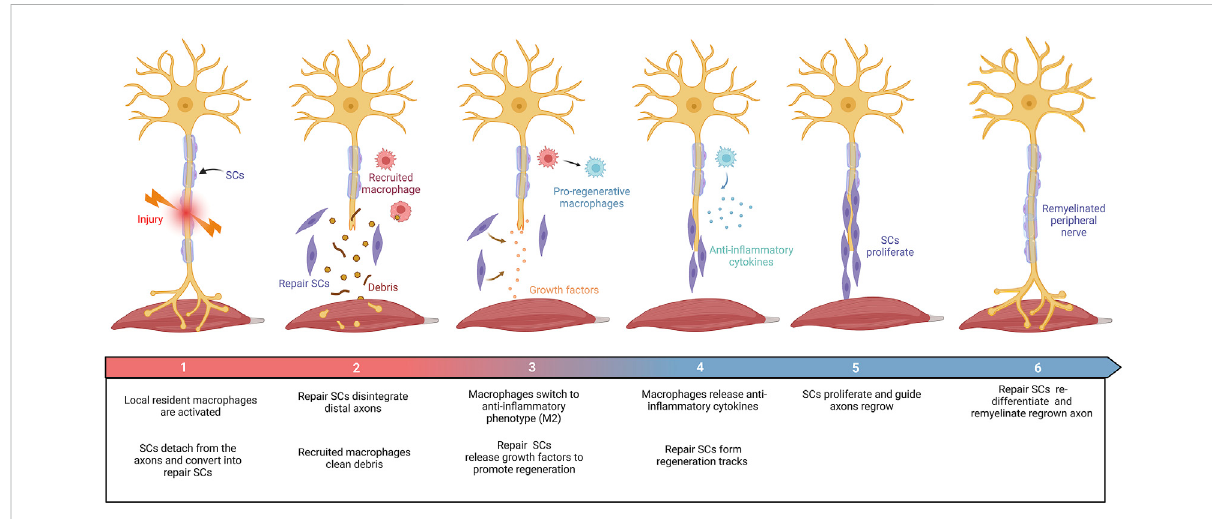
FIGURE 2 SchematicdiagramsummarizingtherepairprocessinthePNI.Damagetoperipheralnerves:(1)SCswererapidlyrespondedandconvertedinto repair SCs. Local resident macrophages are activated. (2) Repair SCs disintegrate distal axons and recruit macrophages to clear debris. (3) Repair SCs release growth factors to promote axon regrowth. Macrophages switch to an anti-in fl ammatory phenotype (M2). (4) Repair SCs form regeneration trackstoguideaxonregrowth.Macrophagessecreteanti-in fl ammatoryfactorsunderthestimulationofthelocalinjuredmicroenvironment.(5) SCs proliferate and guide axon regeneration. (6) Finally, SCs transform into myelinating SCs and remyelinate the regenerated axon. This fi gure was created with